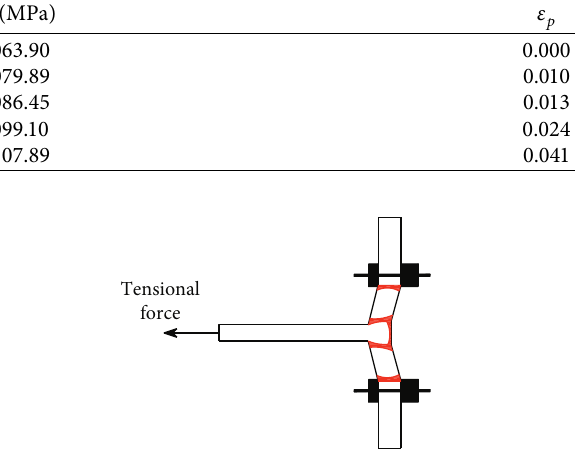
Figure 7: The estimated failure mode of T-stub by analytical method.